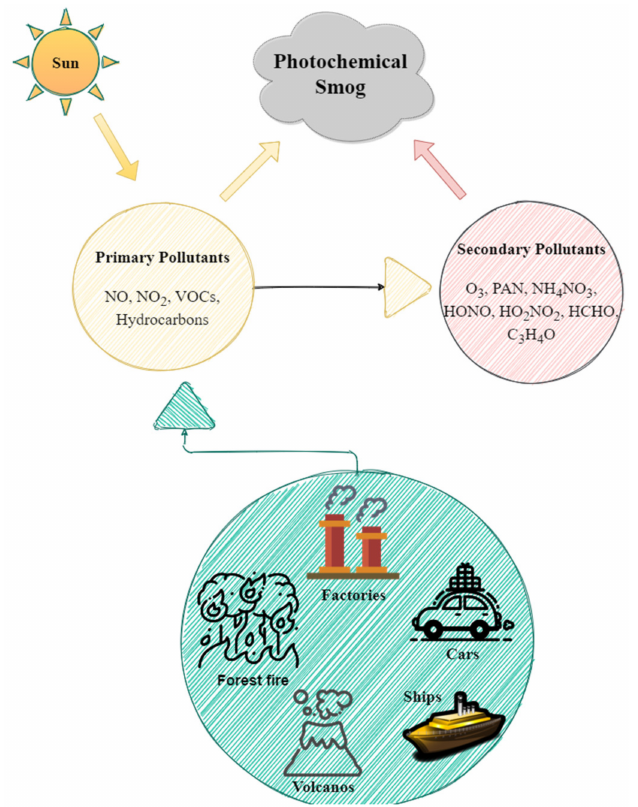
Figure 2. The activities of erupting volcanoes, traffic emissions, forest fires, general combustion, mining, agriculture are directly or indirectly involved in the production of primary pollutants like NO, NO 2 , VOCs, and hydrocarbons which are major forerunners of smog. These primary pollutants undergo chemical reactions in presence of sunlight to form secondary pollutants like formaldehyde, peroxyacetyl nitrate (PAN), and O 3 [40,41]. Both primary and secondary pollutants then concoct smog. Table 1. Distinctive features between London, Photochemical and Natural